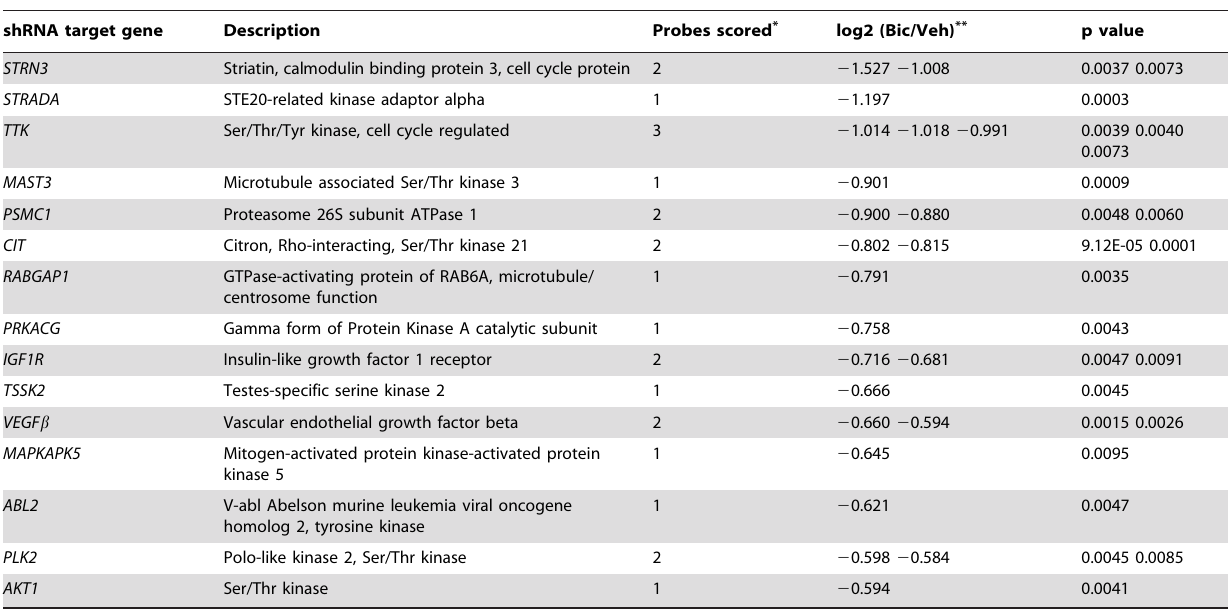
Table 1. Probes depleted in bicalutamide-treated LNCaP cells.